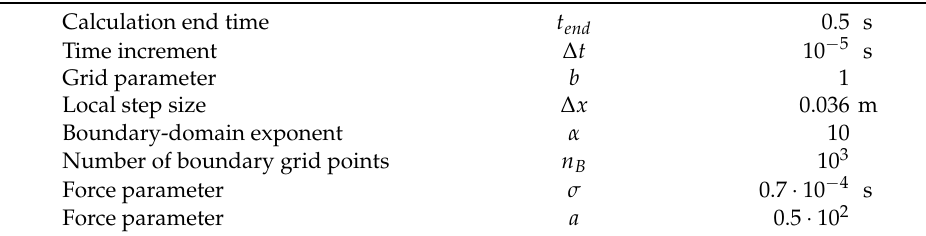
Table 2. Numerical parameters.